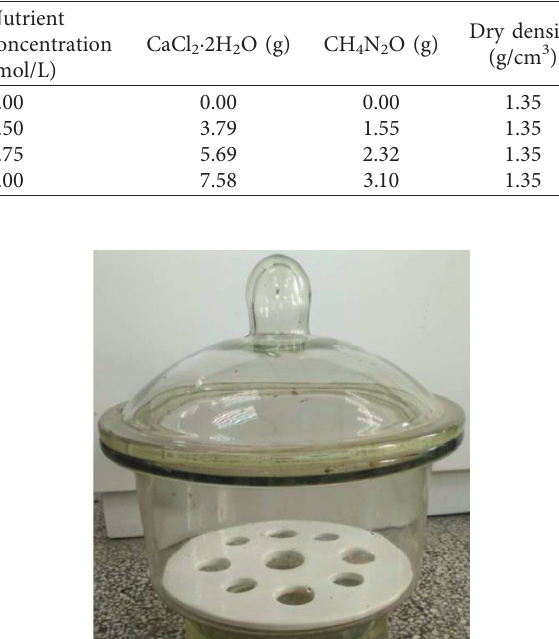
Table 2: Mass of nutrient salts added to the soft clay specimen nutrient concentration groups and concentration group curing times (curing time 28 d).